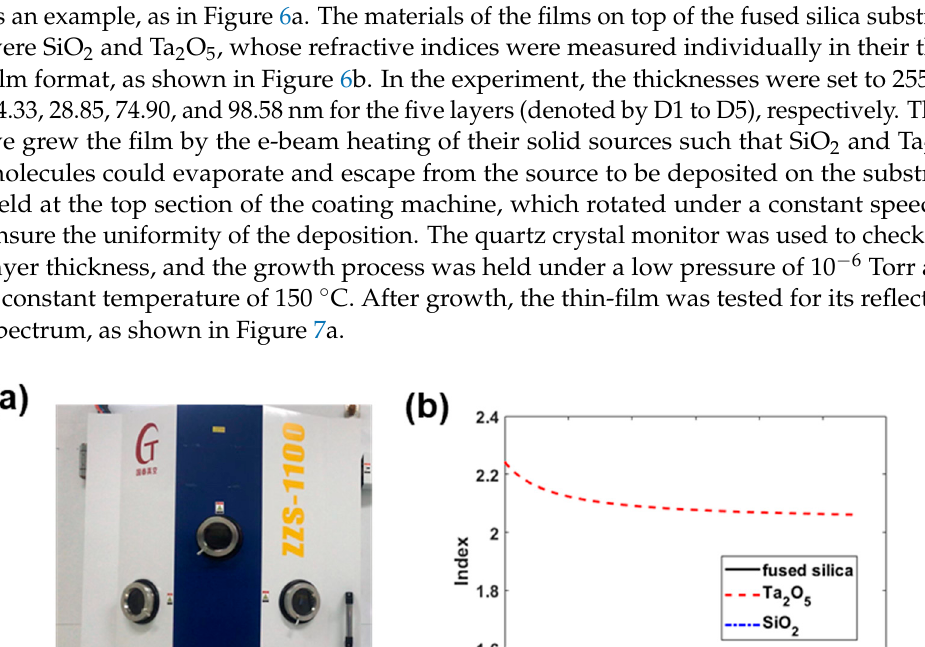
Figure 6. ( a ) The ion-beam-assisted coating system and ( b ) the indices of the materials used in the thin-film growth.